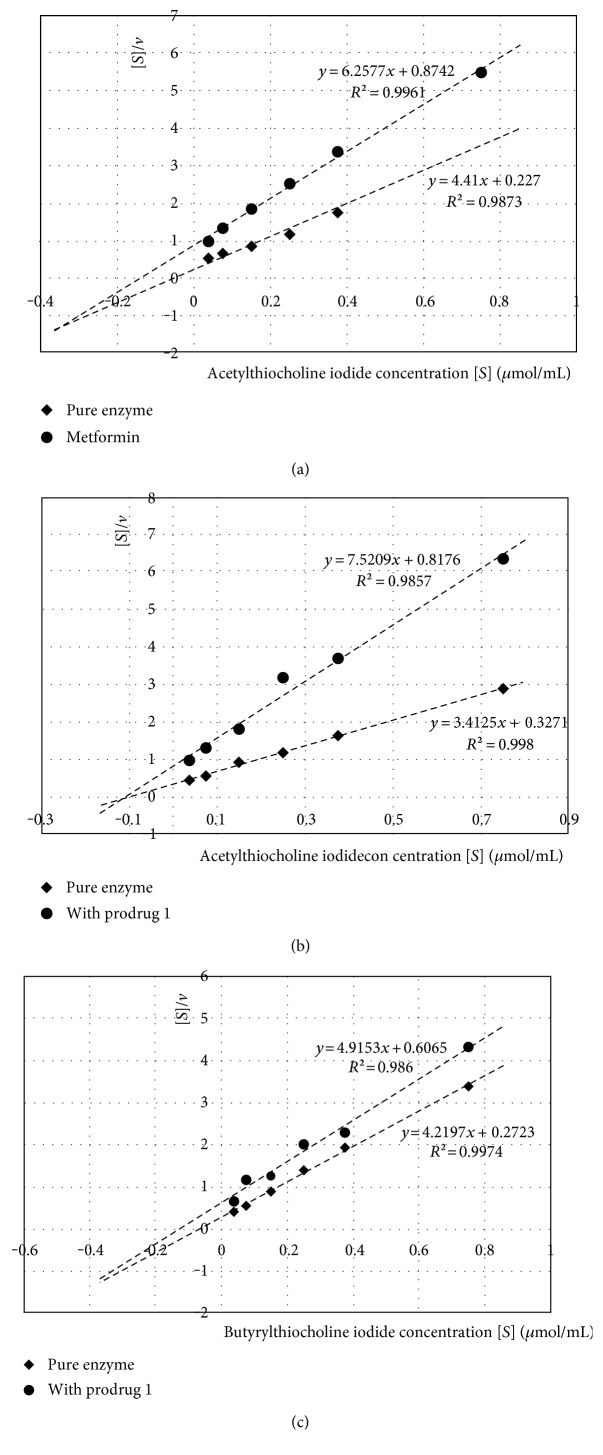
Hanes-Woolf's curves. (a) AChE and metformin at concentration of 2.35 μmol/mL (IC50), mixed-type inhibition; (b) AChE and prodrug 1 at concentration of 0.89 μmol/mL (IC50), noncompetitive inhibition; (c) BuChE and prodrug 1 at concentration of 0.028 μmol/mL (IC50), mixed-type inhibition.